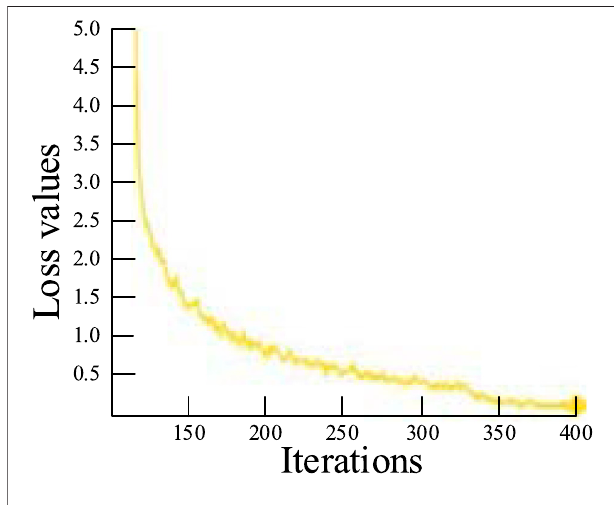
FIGURE 9 | Loss function